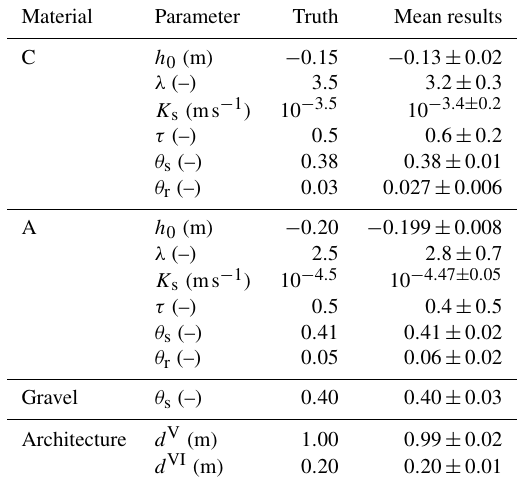
Table 2. The mean and the standard deviation are calculated us- ing the resulting parameters from the 10 best ensemble members (Sect. 3.1.2) estimated from synthetic data. The corresponding ma- terial functions are given in Fig. 10. Notice that the true parameter set lies within the standard deviation of the mean parameter